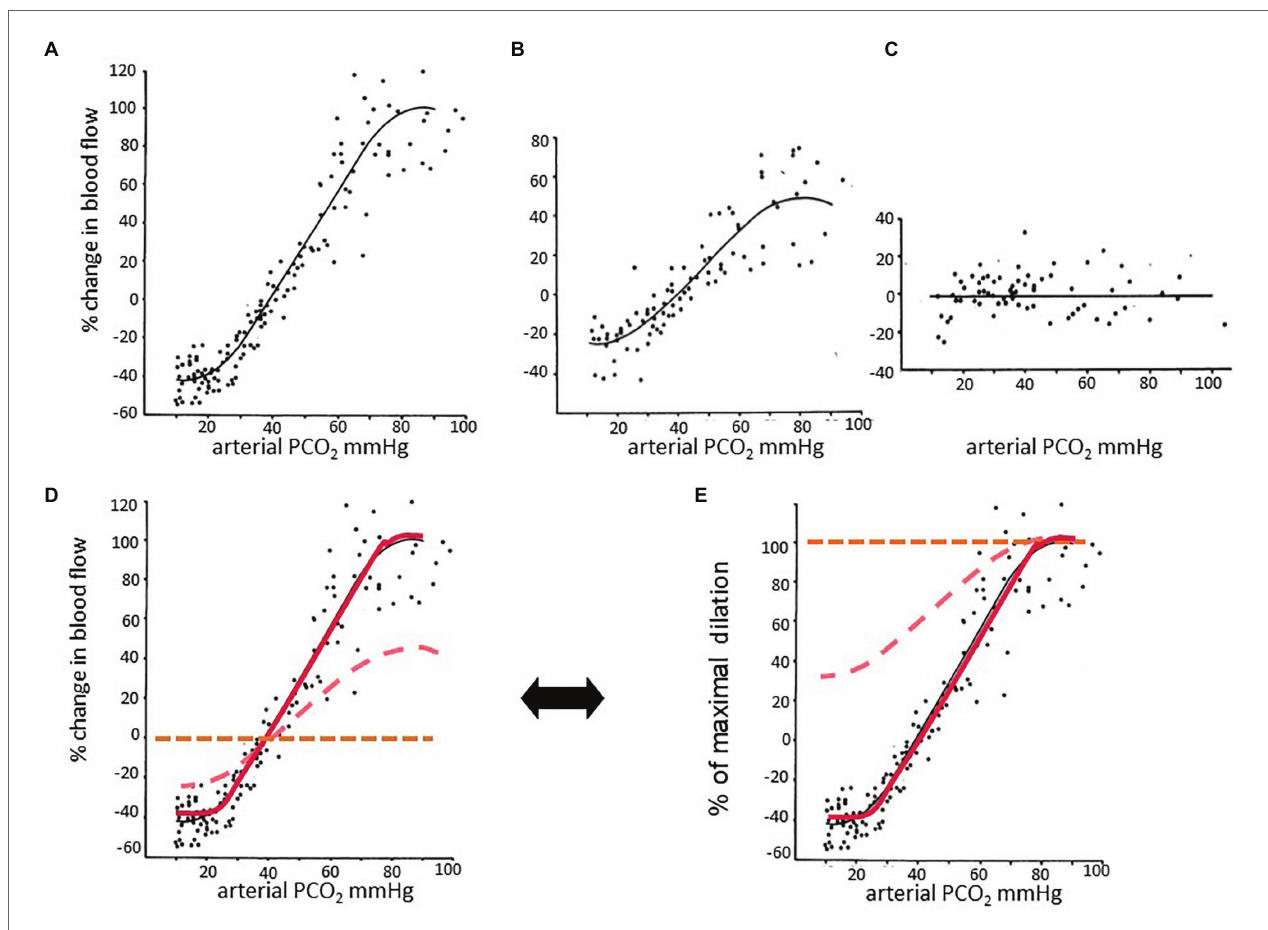
FIGURE 3 | The effect of partial pressure of carbon dioxide (PaCO 2 ) on blood flow at different perfusion pressures. Data taken from Harper and Glass (1965). In this experiment, the authors anesthetized dogs and measured CBF by washout of radioactive counts. Graphs in the top row were taken from the paper and adjusted to the same scale. (A) Normotensive; (B) mild hypotension; (C) severe hypotension. (D) The three graphs are plotted on the same axes. (A) The relationship between PaCO 2 and CBF is sigmoidal. (B) The encroachment on the vasodilatory reserve by perfusion pressure autoregulatory-induced vasodilation reduces the reactivity to carbon dioxide (CO 2 ), as indicated by the slopes of the linear part of the sigmoid curves. Perfusion pressure autoregulation and CO 2 reactivity compete to alter vessel diameter. (C) When autoregulation is exhausted, there is no further response to hypercapnia and little or no constriction to hypocapnia. (D) The midpoints of the sigmoidal curves are approximately at the resting PCO 2 . (E) Percent of maximal dilation. At high PCO 2 , or low blood pressure, vessels are maximally dilated. Healthy vessels in normotensive subjects maintain vascular tone with considerable vasodilatory reserve. Vessels maximizing their autoregulation have minimal vasodilatory reserve. Thus a hypercapnic stimulus of sufficient magnitude will continue to dilate healthy vessels while those that have exhausted their vasodilatory reserve will increase their flow to a lesser extent, or even reduce their flow and suffer